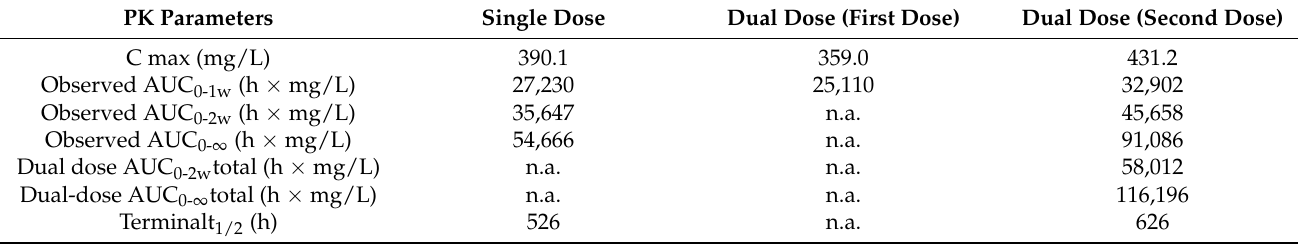
Table 2. Summary of the mean PK NCA of the last dose in the two treatment groups, single vs. dual 1500 mg intravenous doses, administered through 30 min infusion. Total AUCs for dual dose regimen have been calculated by the sum of the first dose AUC 0-1w with the AUC from the second dose (e.g., total AUC 0-2w = first dose AUC 0-1w + second dose AUC 0-1w ). PK Parameters Single Dose Dual Dose (First Dose) Dual Dose (Second Dose)